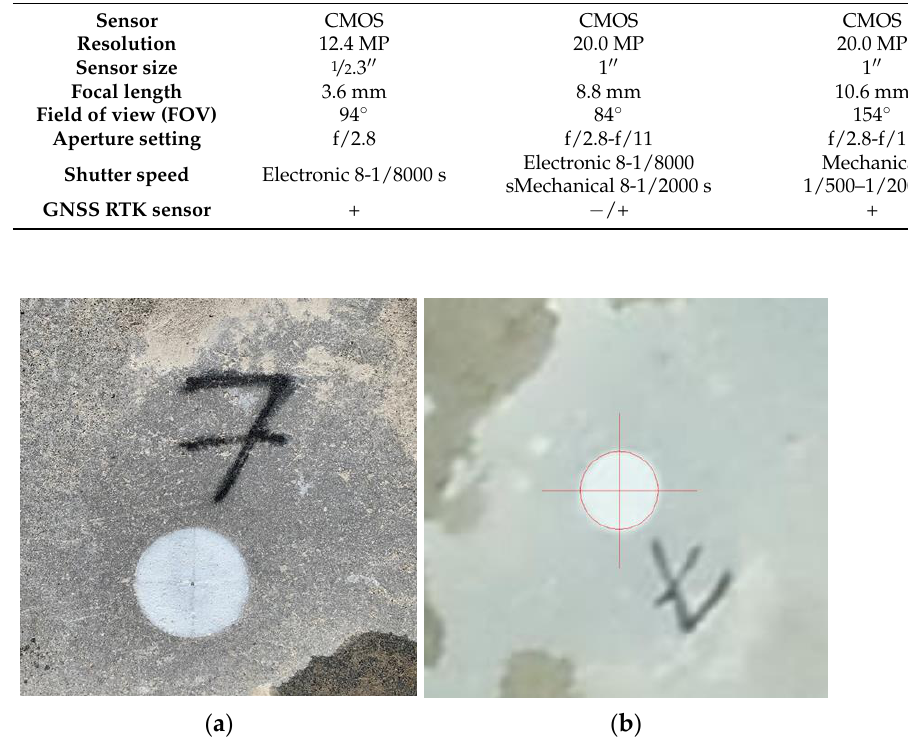
Figure 3. Checkpoint drawn in the field ( a ); CP vectorized on the DOF map ( b ).